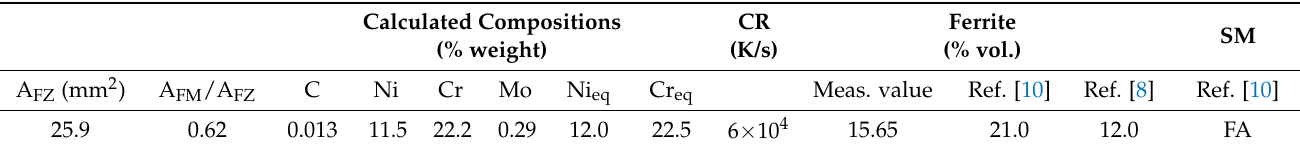
Table 3. FZ composition, cooling rate, ferrite volume (insert made of AWS 309L). Calculated